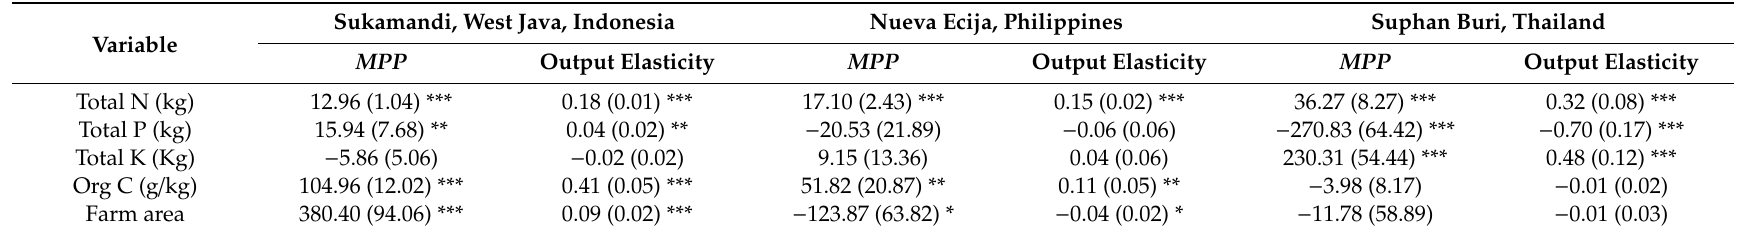
Table 8. Marginal physical product ( MPP ) and output elasticity at the mean level in Indonesia, Philippines, and Thailand.